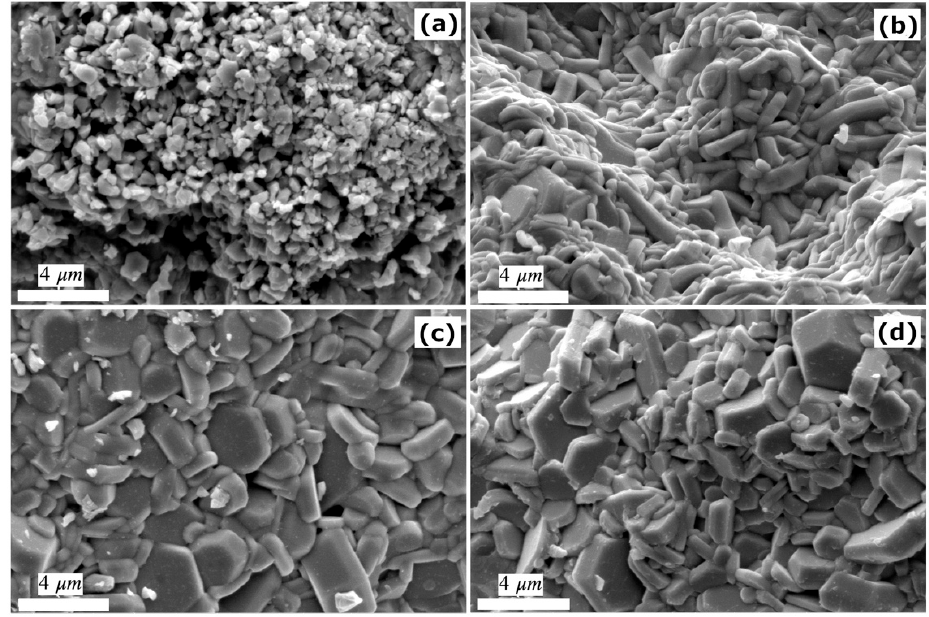
Figure 2. SEM micrographs of BaFe 12 − x Cu x O 19 ; ( a ) x = 0, ( b ) x = 0.1, ( c ) x = 0.3, and ( d ) x = 0.5.